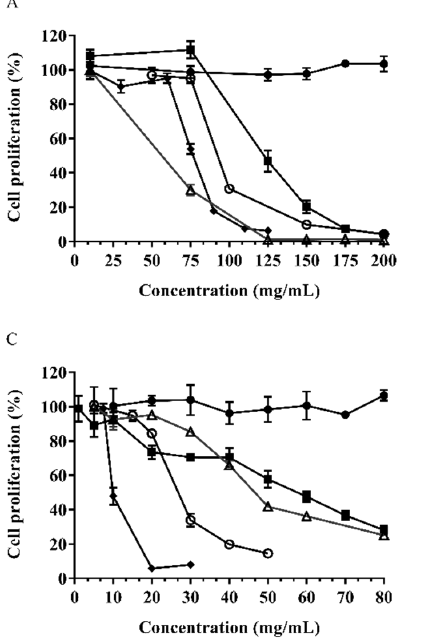
Figure 3. Percent inhibition of cancer cells’ proliferation by pistachios (raw and roasted). ( A ): HepG2 cells, ( B ): Caco-2 cells, ( C ): MDA-MB-231 cells. ( ● ) control; ( △ ) raw–bound; ( ) raw–free; ( ■ ) roasted–bound; ( ) roasted–free. Table 5. Vitamin E and carotenoids profiles of pistachios (raw and roasted) (Independent T-test). Pistachios Raw Pistachios